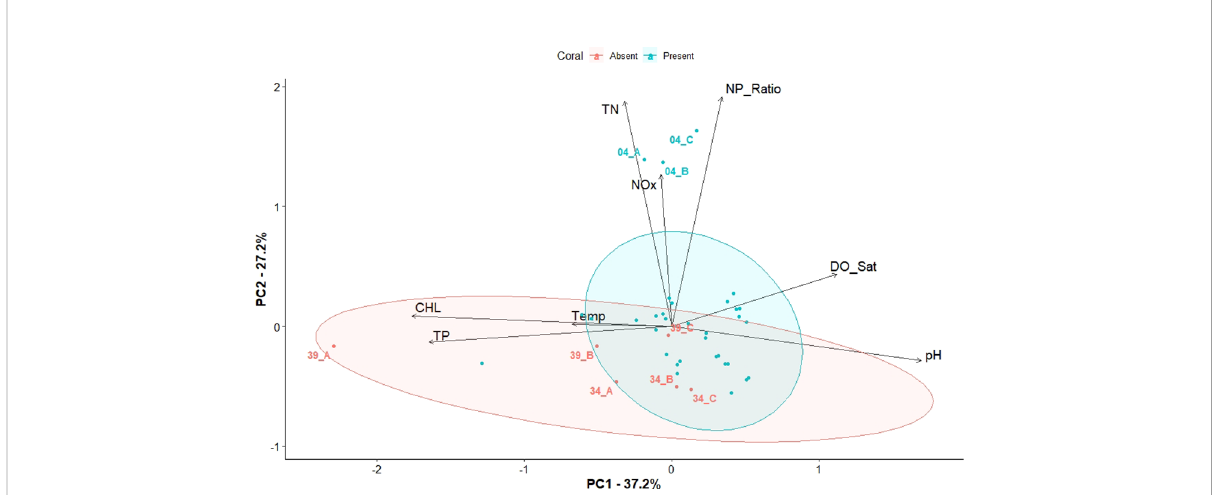
FIGURE 7 Principal Component Analysis (PCA) biplot representing both PC of sites (depicted as dots) and water quality parameters (depicted as arrows). The length of the arrows represents the level of in fl uence they have on the corresponding PC. Coral present sites are shown in blue color, while coral absent sites are shown in red color. Concentration ellipses are drawn around the 0.90 con fi dence